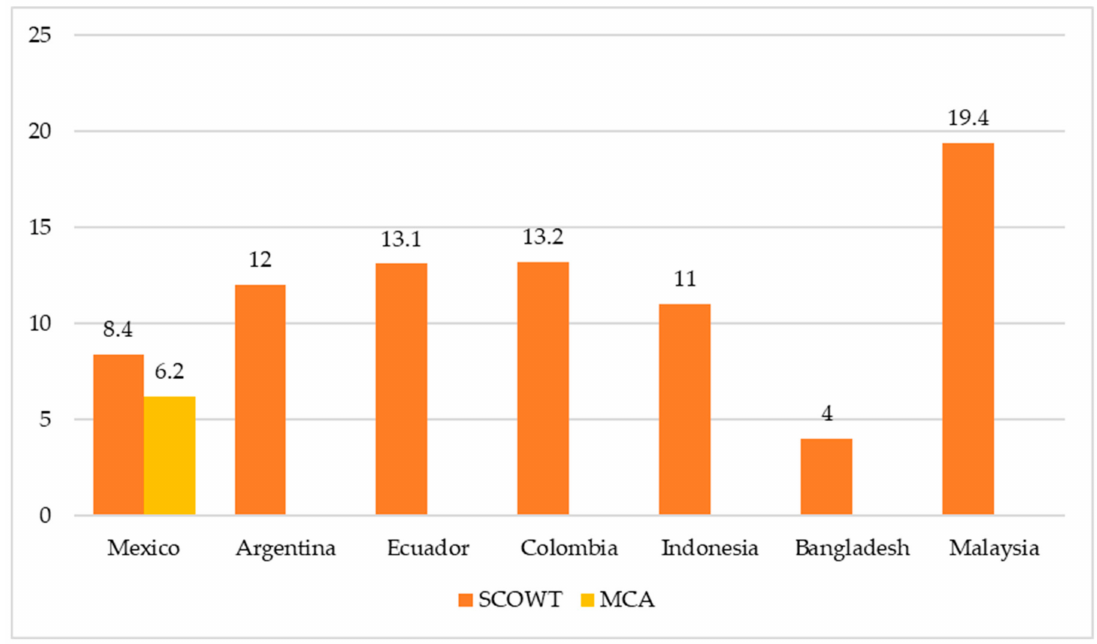
Figure 1. Prevalence of double burden of malnutrition (DBM) in developing